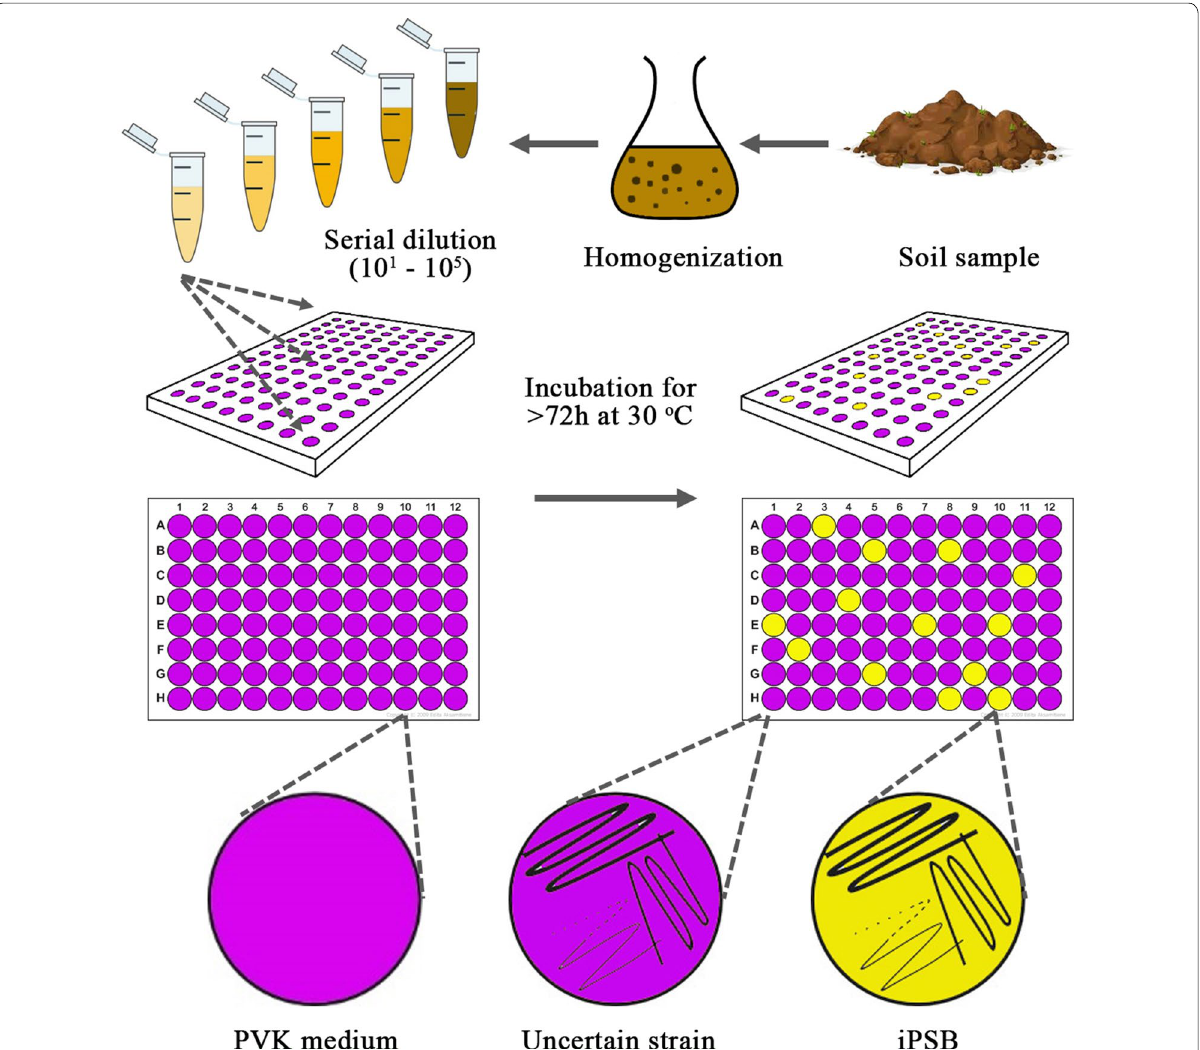
Fig. 1 Flowchart of the 96‑well iPSB screening method. The sampled soil was homogenized in autoclaved water and serially diluted for incubation at 30 °C for > 72 h in 96‑well microplates containing PVK with bromocresol purple as an indicator. Wells with no color change or strain growth, or with strain growth but no color change, were classified as containing unknown strains without P‑solubilizing ability. Wells that produced a yellow color were classified as containing iPSB